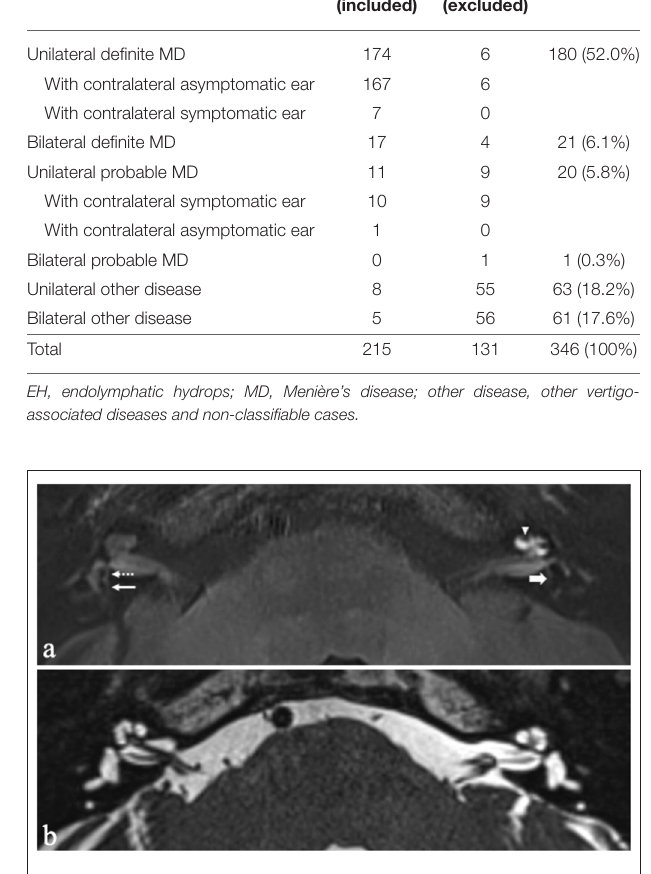
Subjects with EH (included)